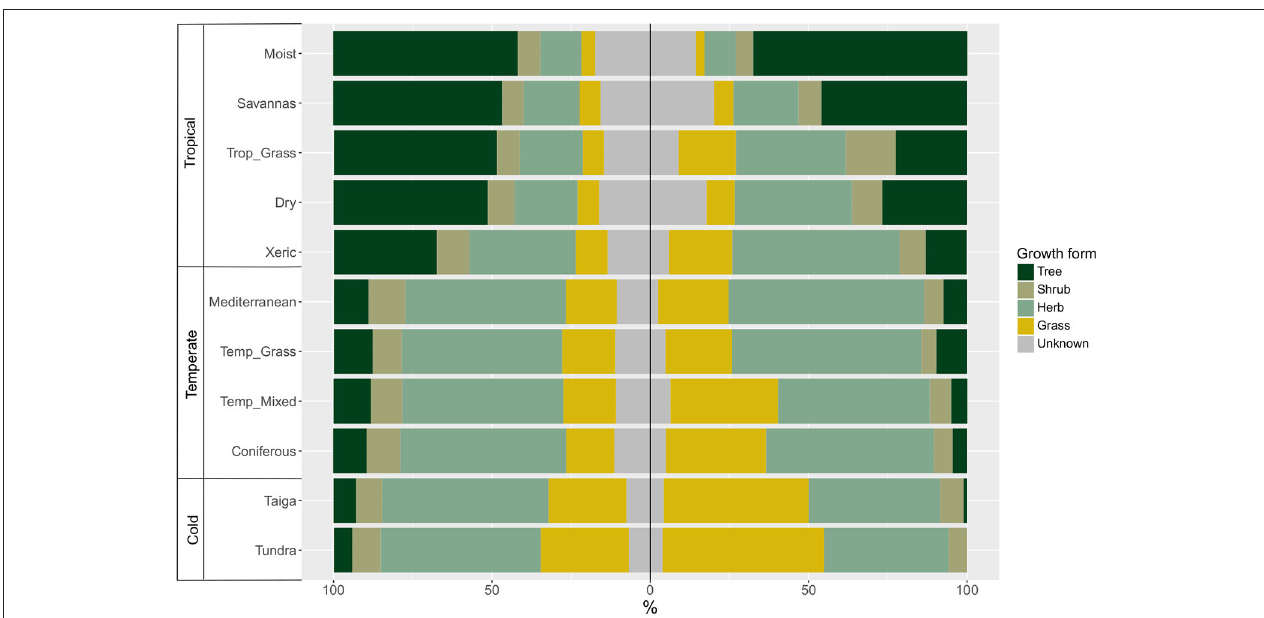
FIGURE 4 | Distribution of growth forms in each biome (left) using the total number of species, and (right) using only those species that are functionally similar and widespread within the biome (see Figure 3